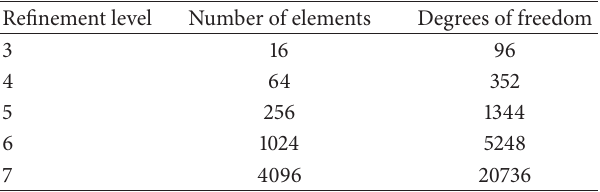
Table 1: Mesh statistics at different refinement